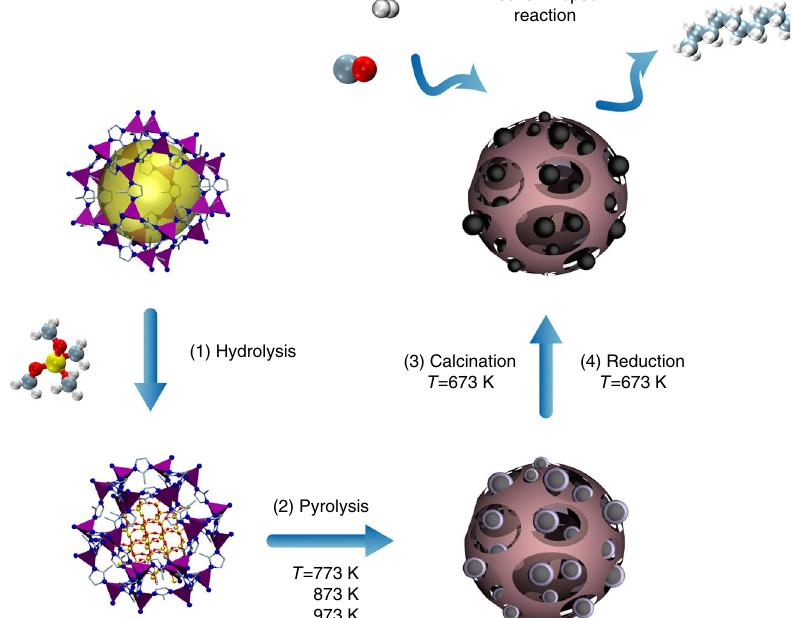
Fig. 1 Schematic illustration of the synthesis of the Co@SiO 2 catalysts. ( 1 ) Impregnation and hydrolysis of TMOS molecules in the porosity of ZIF-67. ( 2 ) Pyrolysis of the mixture of ZIF-67@SiO 2 in N 2 to decompose ZIF-67 and form Co@C-SiO 2 . ( 3 ) Calcination of the Co@C-SiO 2 in air leads to carbon removal and oxidation of Co. ( 4 ) Reduction of the Co@SiO 2 in H 2 leads to the formation of metallic Co for Fischer – Tropsch synthesis. The resulting composite is an excellent catalyst for the low temperature Fischer – Tropsch